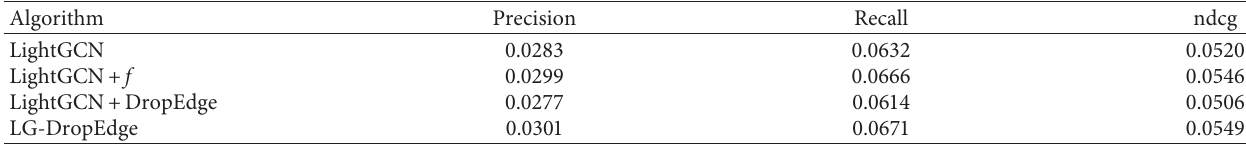
Table 5: Performance of the Yelp2018 dataset under the four